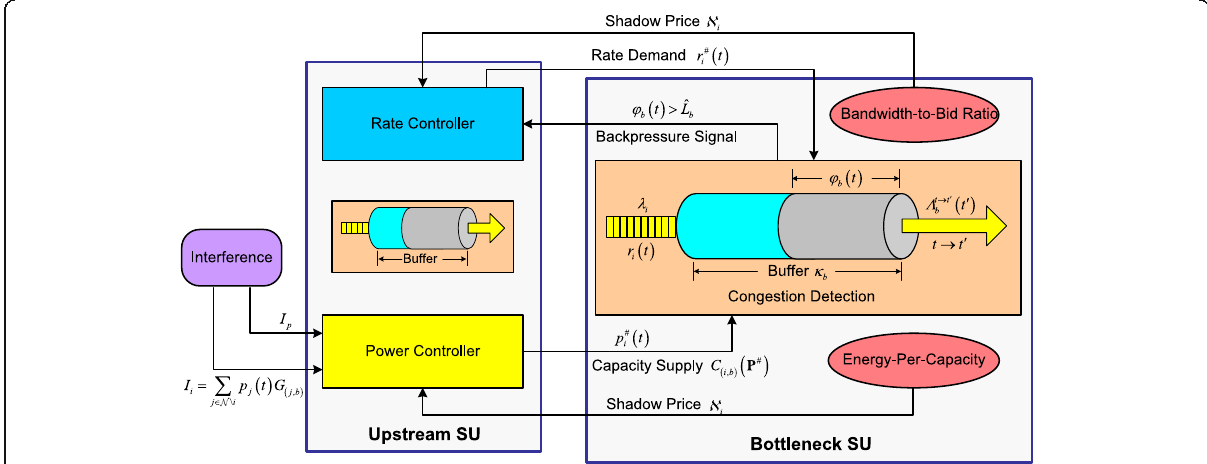
Fig. 3 Illustration of cross-layer optimization framework for hop-by-hop congestion control and per-link power control